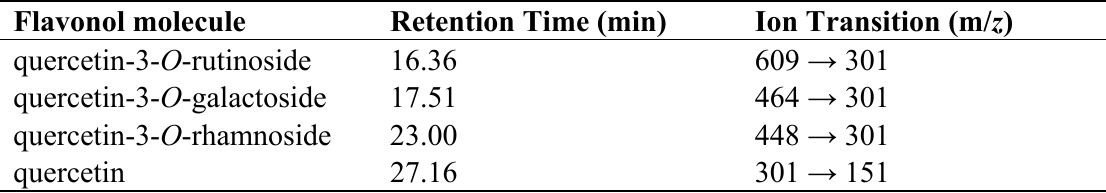
Table 3. Retention times and ion transitions for flavonols quantified in apple peel powder using HPLC-MS/MS using multiple reactions monitoring (MRM)